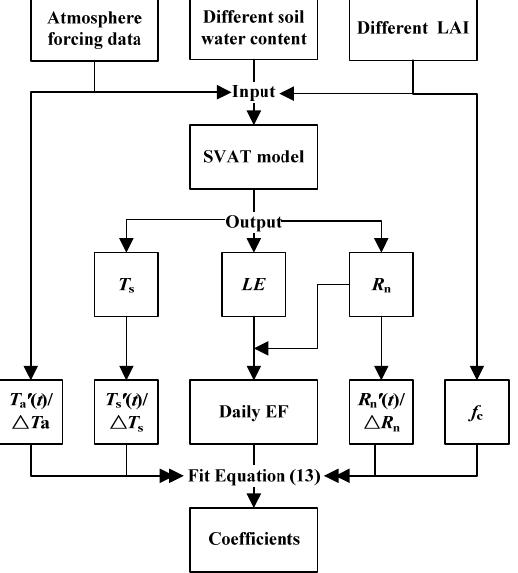
Figure 8. Flow chart for obtaining the coefficients in Equation (13) using the SVAT-simulated data.